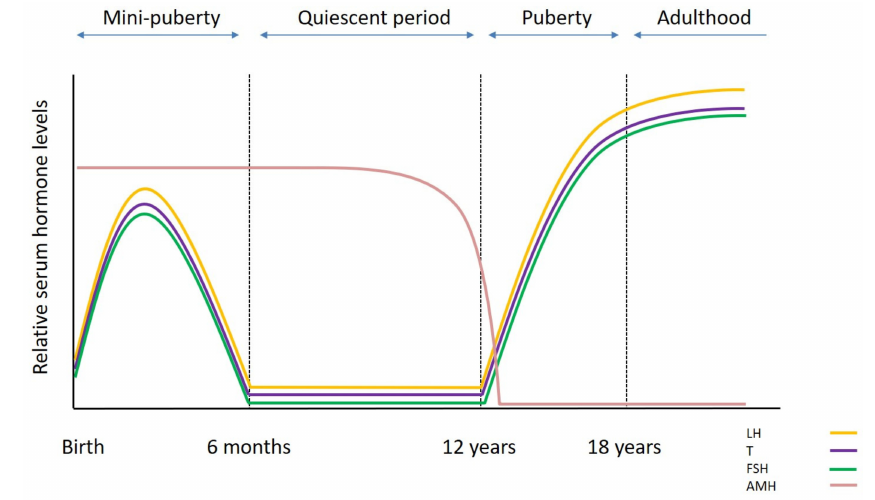
Figure 2. Hormonal levels in males from birth till